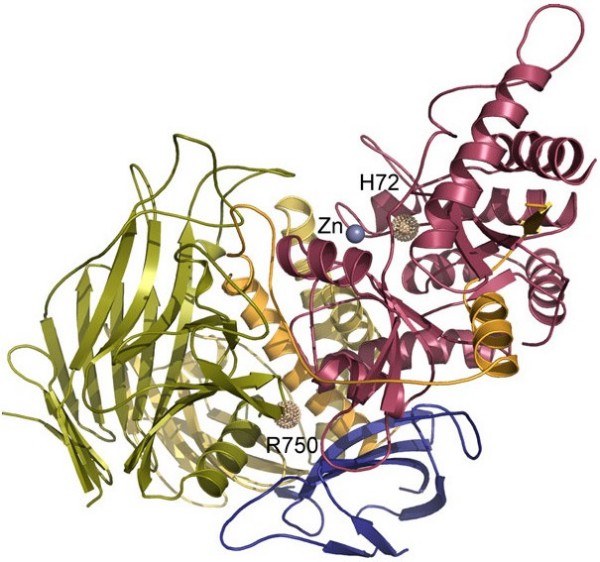
The 3-dimensional structure of lysosomal α-mannosidase. Peptides are coloured a-red, b-orange, c-yellow, d-green and e-blue. The active site is denoted by a Zn++ ion. Two mutant sites are displayed, demonstrating the effect of mutations c.215A>T: p.H72L affecting Zn++ coordination in the actives site (group 1 mutation, see text for explanation) and the prevalent mutation c.2248C>T: p.R750W which is likely affecting peptide e-d interaction (group 2 mutation, see text for explanation). The figure was kindly provided by Dr. P. Heikinheimo, University of Helsinki, Finland. It has been prepared with the program PyMol [72].